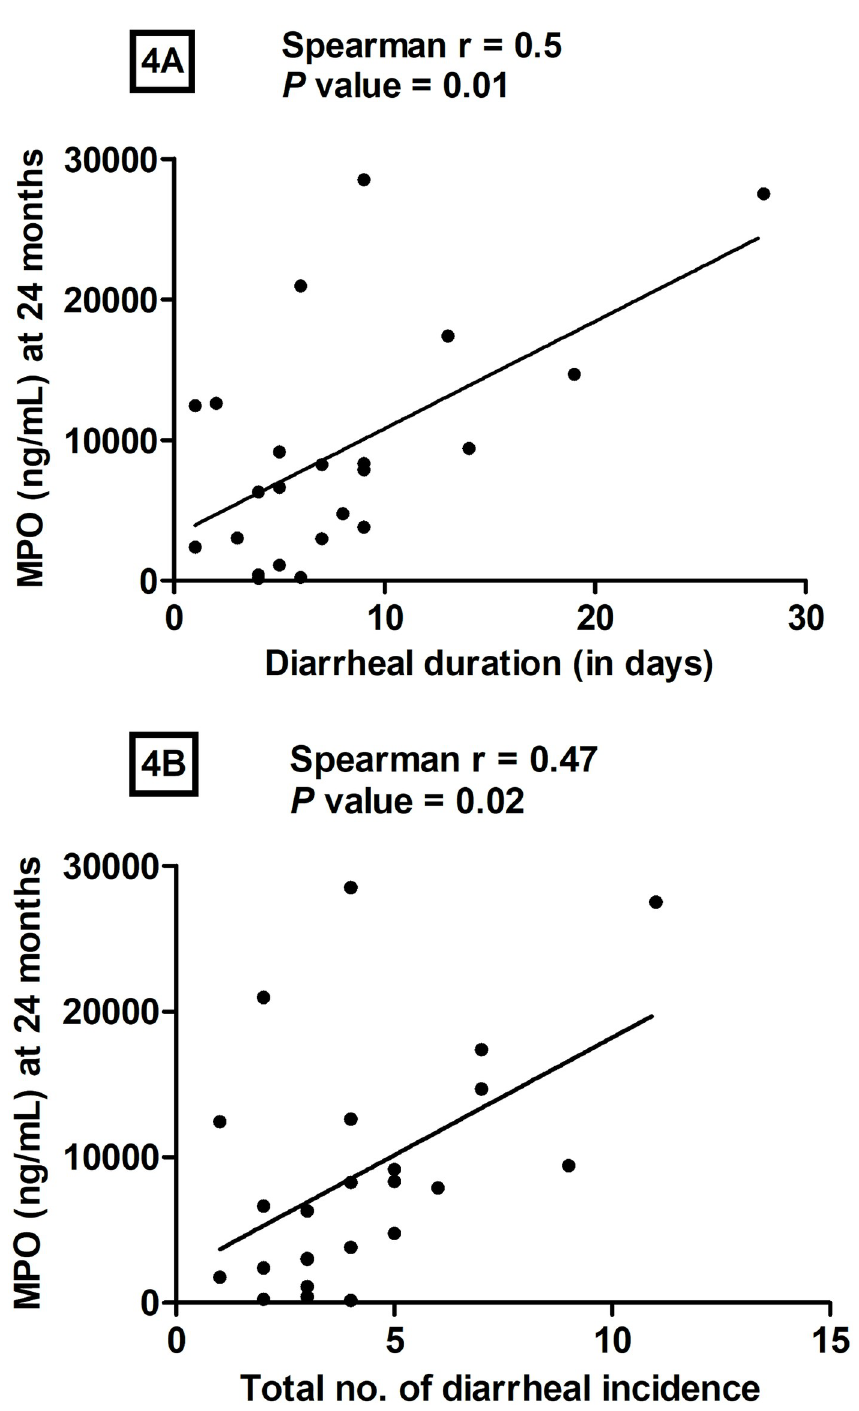
Fig 4. Correlation of diarrheal duration (n = 23) and the total number of diarrheal episodes (n = 24) with fecal MPO levels at 24 months. The X-axis indicates diarrheal duration (4A) and the number of individual diarrheal episodes (4B), while the Y-axis denotes MPO levels (ng/mL) at 24 months of age (4A and 4B). We performed the Spearman correlation test for statistical evaluation [r = 0.5 and P = 0.01(4A), r = 0.47 and P = 0.02(4B)]. Diarrheal duration denotes the total number of days over the two years when a child had diarrhea